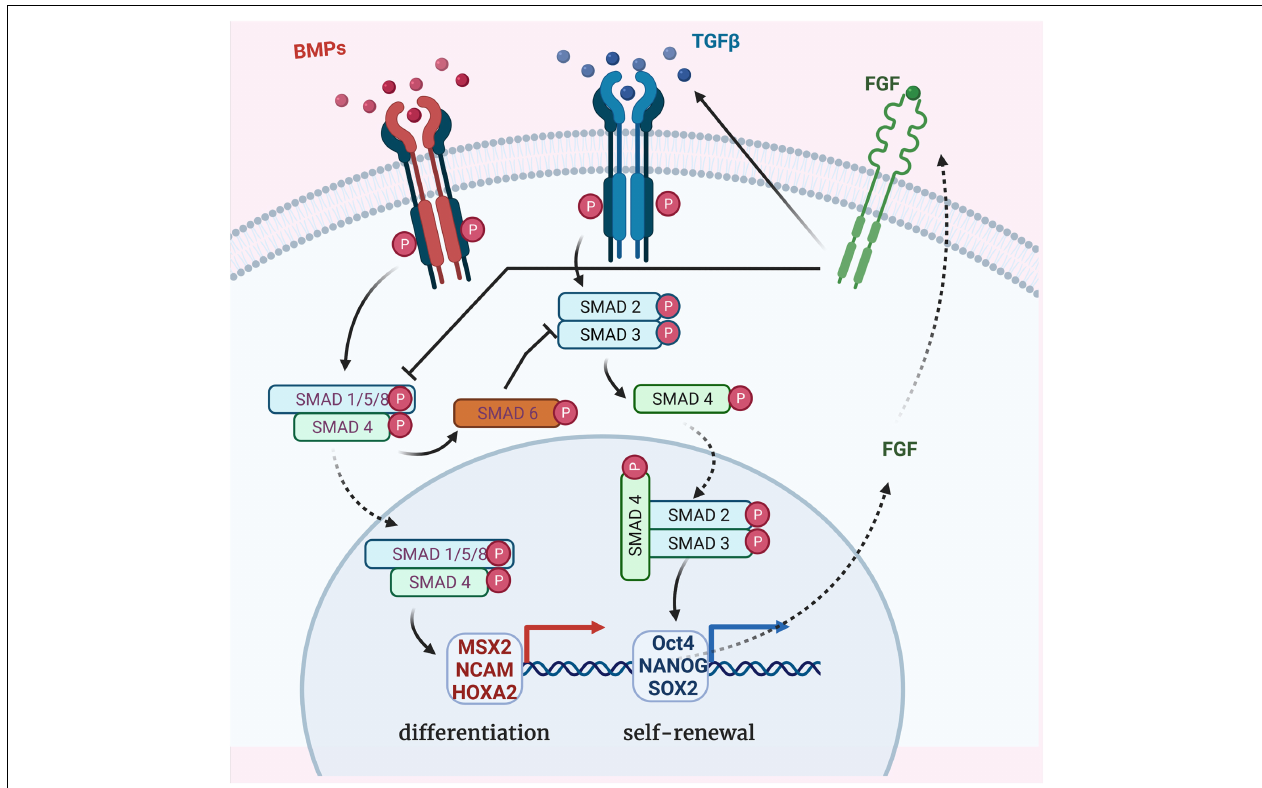
FIGURE 1 | Bone morphogenetic protein (BMP), TGF- β , and FGF-dependent SMADs pathways for regulation of stem cell differentiation. TGF- β super-family members binding to the receptors which propagate phosphorylation signal to receptor-regulated SMAD proteins (R-SMADs in blue). BMP signaling occurs through SMADs 1/5/8 phosphorylation and TGF- β signaling through SMADs 2/3 phosphorylation. Once activated, their binding with the common partner (Co-SMAD in green) SMAD 4 results in complexes which translocate to the nucleus to activate other transcription factors and regulate specific genes expression. MSX2, NCAM, and HOXA2 expression leads to the differentiation of ESCs whereas Oct4, NANOG, and SOX2 expression contributes to the undifferentiated proliferation. BMP signaling negatively regulates TGF- β signaling via the expression of the inhibitory SMAD 6 (I-SMAD in orange). FGF signaling promotes TGF- β receptor (TGFBR1) activation, resulting in self-renewal transcription factors activation and, in turn, FGF expression. FGF signaling also directly represses SMAD1/5/8 phosphorylation, inhibiting the BMP